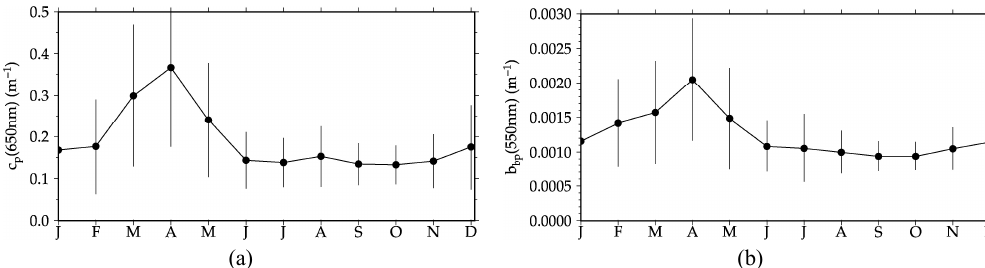
Figure 6. (a) Average seasonal cycles at BOUSSOLE of the particulate beam attenuation coefficient at 650 nm and (b) the particulate backscattering coefficient at 550 nm, from the buoy data collected from 2003 to 2019 (depth < 10 m).